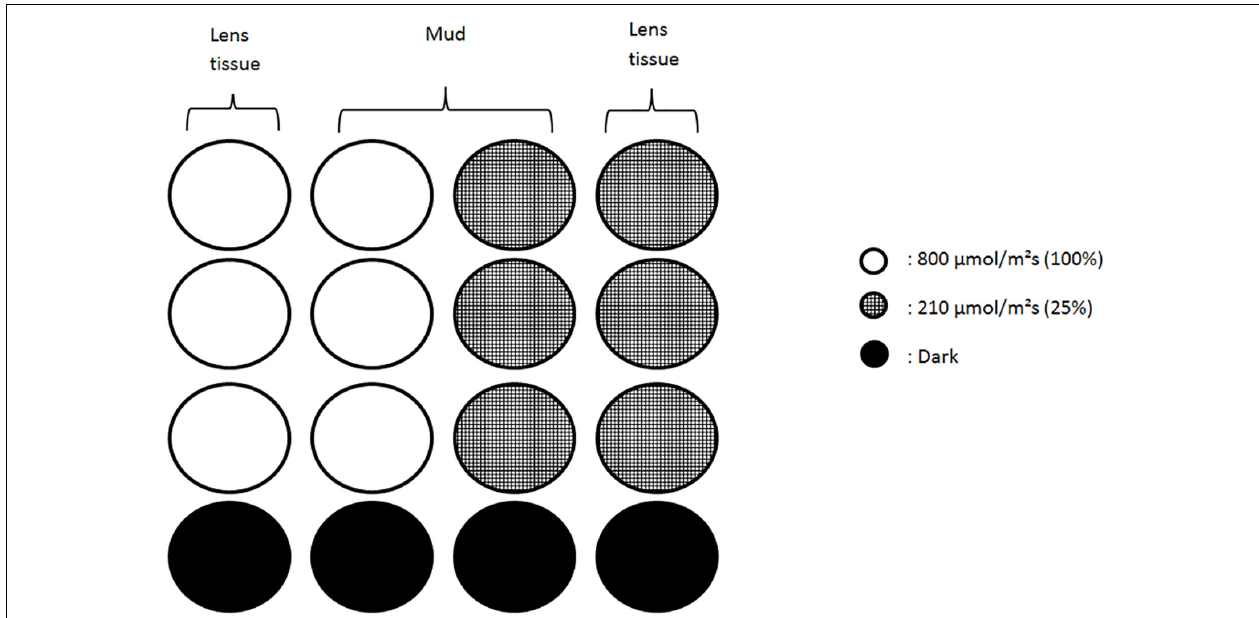
FIGURE 1 | Schematic of the wells set up under each color. Each column of four wells was independently bound and contained three replicates and a dark control. Lens tissue wells were filled with a suspension of migrating diatoms collected from the mud. Wells with mud contained natural assemblages of algae/diatom dominated by epipelic species. Low light conditions (210 µ mol.photons.m − 2 .s − 1 ) were obtained using neutral filters.